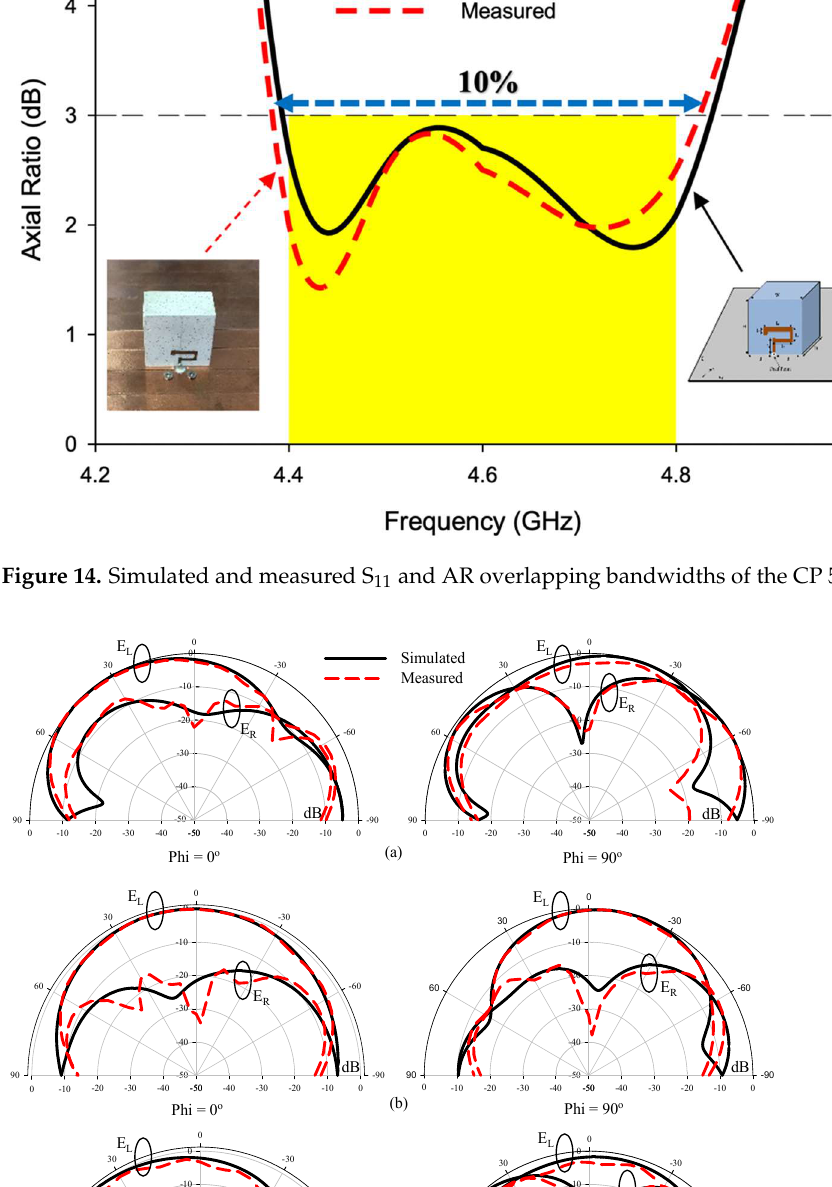
Figure 15. Simulated and measured radiation patterns of the CP 5G RDRA. ( a ) 4.4 GHz; ( b ) 4.43 GHz; ( c ) 4.7 GHz.